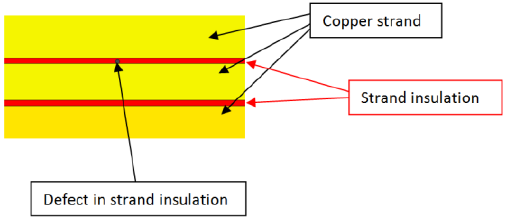
Figure 12. The defect is between two strands. It can be a void or a local rip in the layer. It can act as a short circuit between strands.